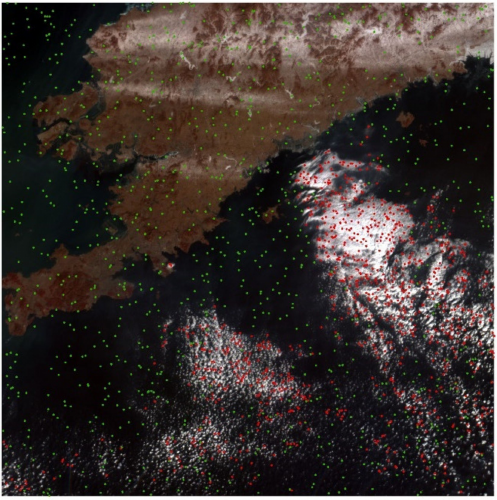
Figure 7. Classification of clouds and background in the Liaoning area using the RTD method (left) and SVM method (right).